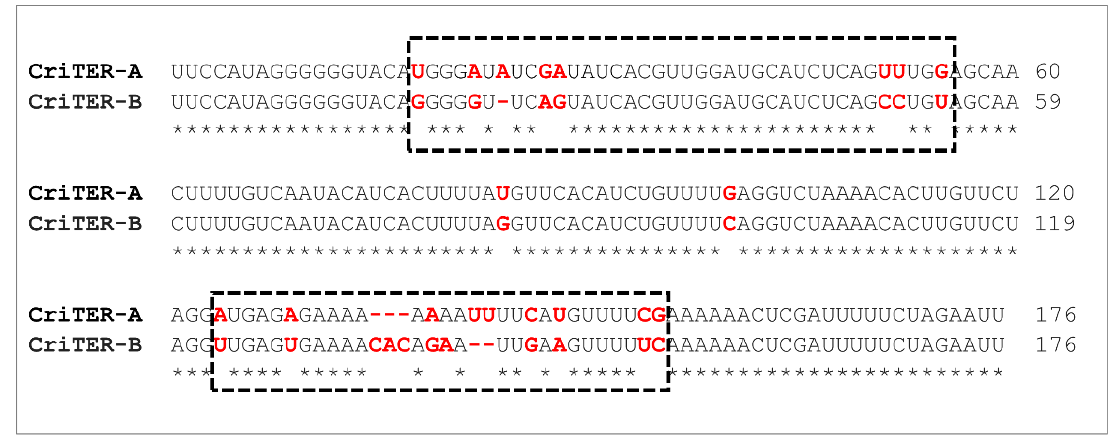
Figure 2. Sequence alignment of monomeric units of the telomeric CriTER-A and CriTER-B ncRNAs. Pairwise sequence alignments performed with EMBOSS Water Web services (default options, https://www.ebi.ac.uk/Tools/psa/emboss_water/, accessed on: 25 August 2021). Sequence variations are denoted in red. Two regions accumulating most of the dissimilarities are highlighted with a dashed line box .